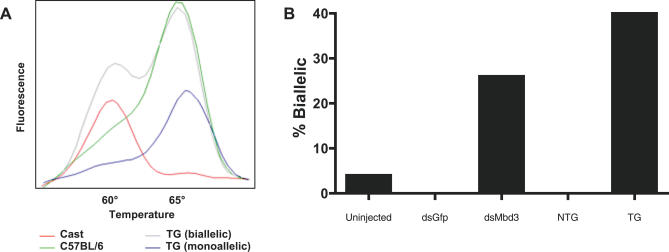

H19 Is Derepressed at the Paternal Allele after Mbd3 RNAiOne-cell C57BL/6J X B6(CAST7) embryos were injected with dsRNA, cultured to the blastocyst stage, and collected singly for RNA extraction. Similarly, TG and NTG embryos were either cultured as above or collected from mothers at 3.5 dpc. Real-time RT-PCR with allele-specific hybridization probes was used to determine H19 expression from each allele, as shown in (A). Shown are the melting curves of the control samples along with a biallelic TG and monoallelic TG sample (the melting curves for the ten other samples processed at the same time are omitted for clarity). The red curve is the melting curve of a Cast control (probe melts off at 60 °C) and the green represents a C57BL/6J control (probe melts off at 65 °C). The grey curve is one of the biallelic TG blastocysts, with two peaks corresponding to the paternal Cast allele and the maternal C57BL/6J allele. The blue curve is a TG sample that is monoallelic for H19 (maternal C57BL/6J allele only). (B) H19 is biallelically expressed in 26% (9/35) of dsMbd3 injected embryos. This is significantly different from controls (p < 0.01 compared to uninjected [2/46] and p < 0.01 compared to dsGfp injected [0/28]). Most control embryos (uninjected and dsGfp) express only the maternal H19 allele. In the Zp3-dsMbd3 TG embryos, 40% (15/38) of TG embryos show biallelic expression of H19. None (0/5) of the NTG controls showed biallelic expression.